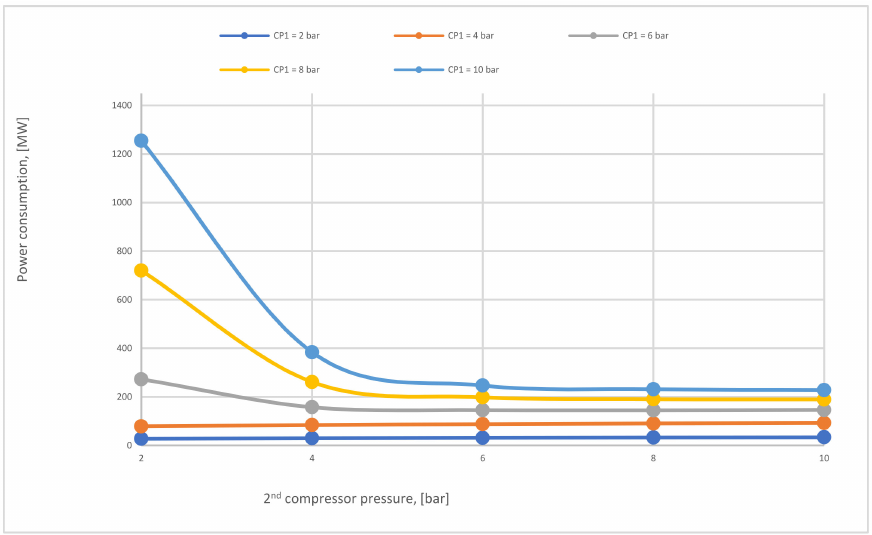
Figure 16. The total power consumption required for 2-stages of the membrane (case C) regarding different 1st and 2nd compressor pressures at SA 1 of 600,000 m 2 and SA 2 of 20,000 m 2